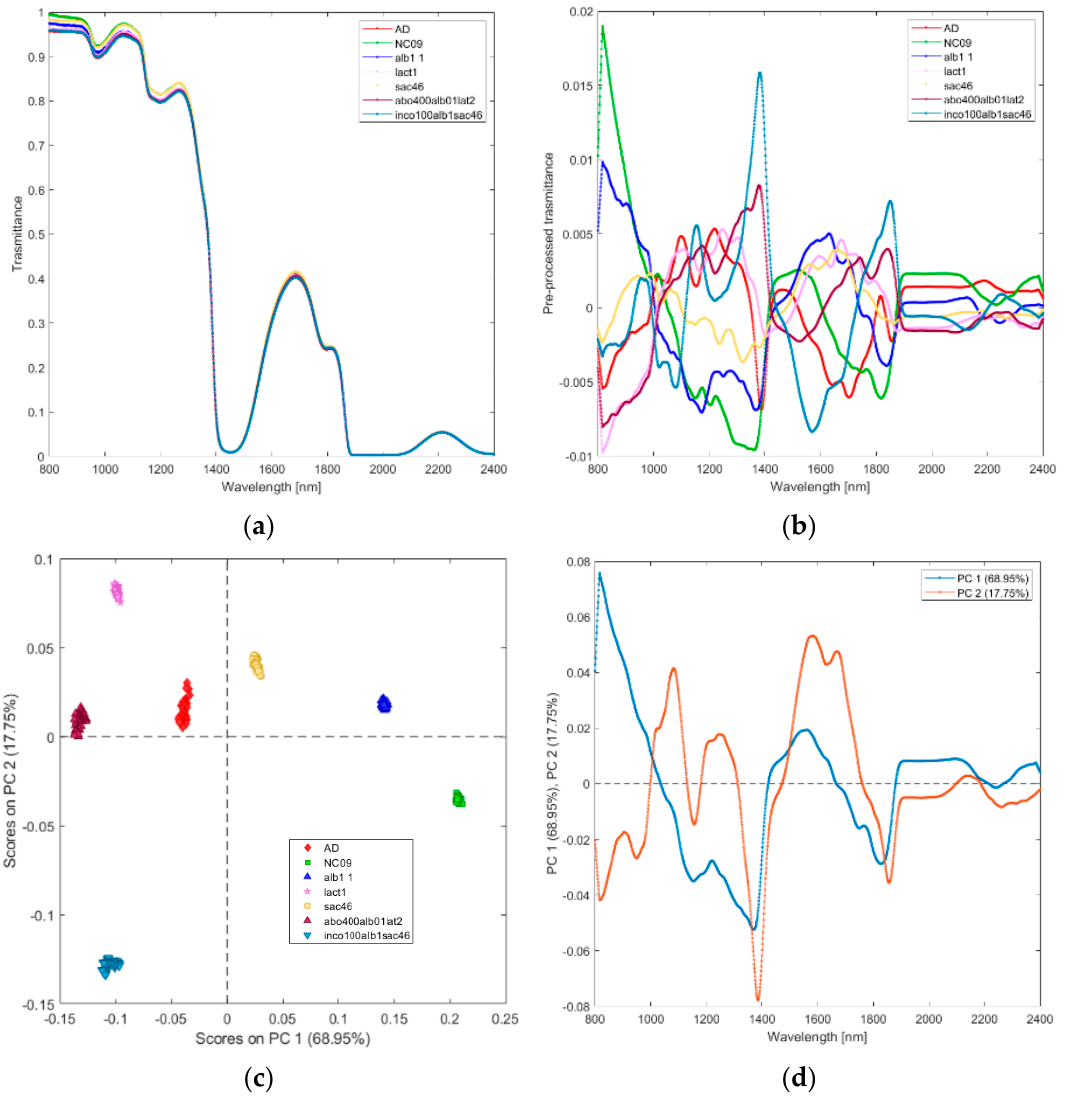
Figure 2. Average raw ( a ) and pre-processed ( b ) transmittance spectra for solutions of incobotulinum A toxin (inco100alb1sac46), abobotulinum A toxin (abo400alb01lat2), HSA (alb1), sucrose (sacc46), lactose (lact1), saline (NaC09), and water (AD). PC1 − PC2 score plot ( c ) and loading plot of PC1 and PC2 ( d ) for incobotulinum A toxin (inco100alb1sac46), equiactive abobotulinum A toxin (abo400alb01lat2), HSA (alb1), sucrose (sacc46), lactose (lact1), saline (NaC09), and water (AD). (ii) Solutions of incobotulinum A toxin (inco100alb1sac46), abobotulinum A toxin